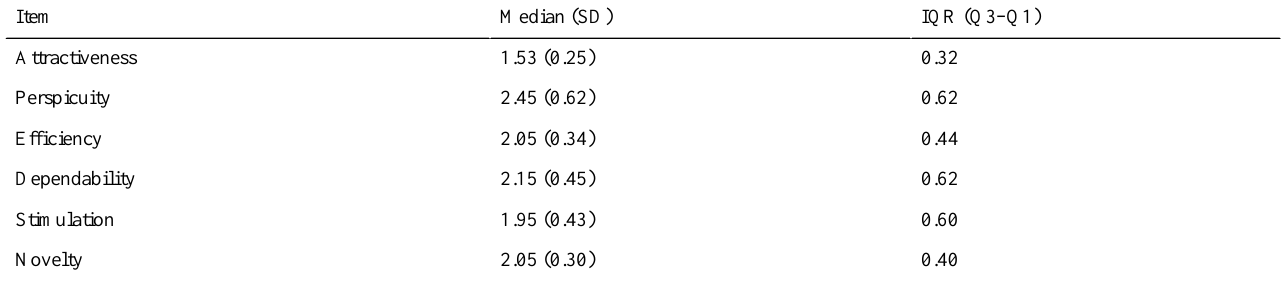
Table 2. Results of the User Experience Questionnaire completed by health care providers